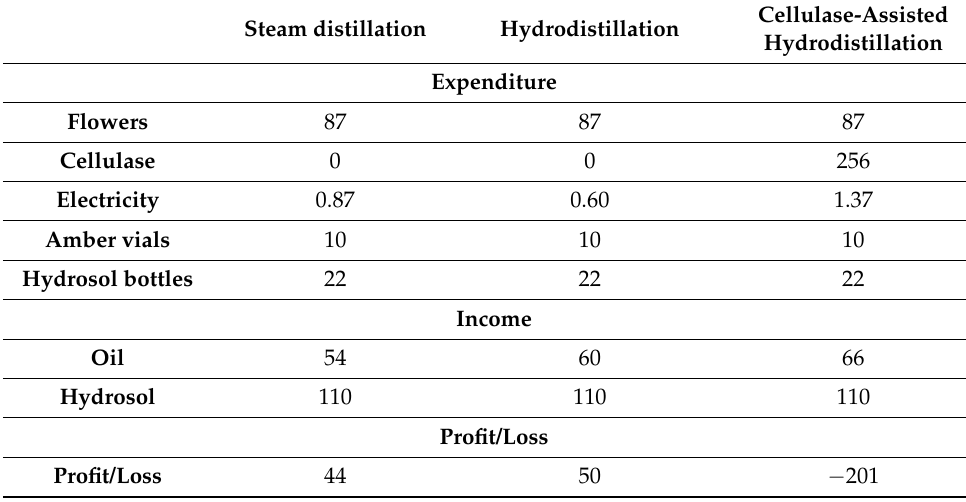
Table 2. Comparison of the income and expenditure of the lavender oil extraction processes using three different extraction methods (costs in USD). Steam distillation Hydrodistillation